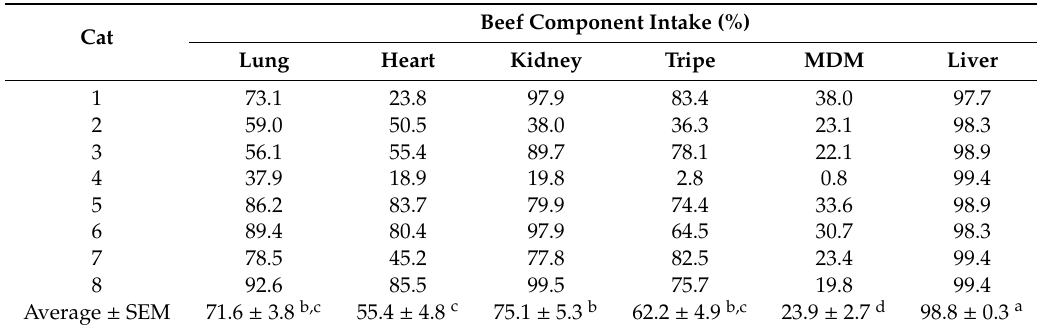
Table 2. Weekly percentage consumption results and final ranking of acceptance for the six beef components. Beef Component Intake (%) Cat Lung Heart Kidney